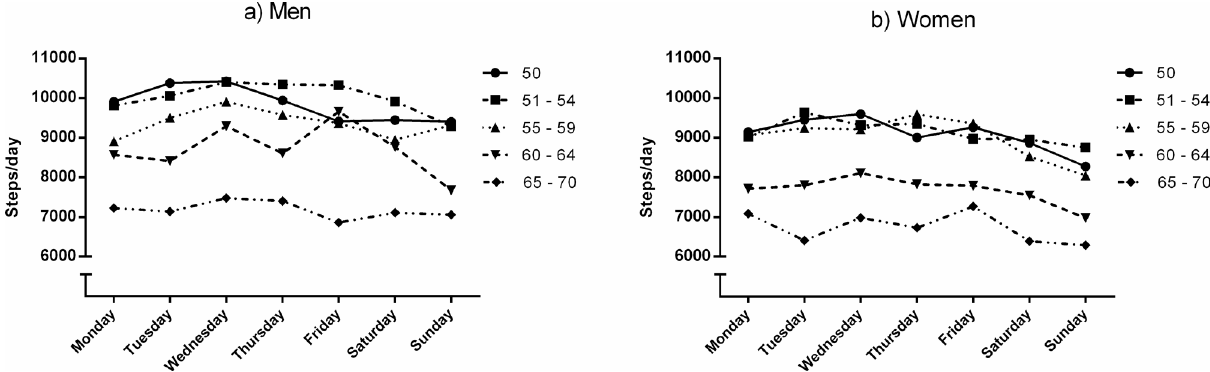
Differences in means and standard deviations of steps/day values on weekdays and weekend days in men (a) and women (b) of different BMI groups (*p < .05).